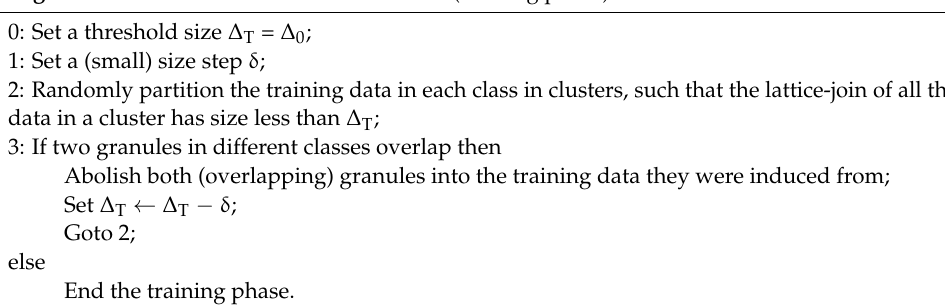
Algorithm 1. GbC: Granule-based-Classifier (training